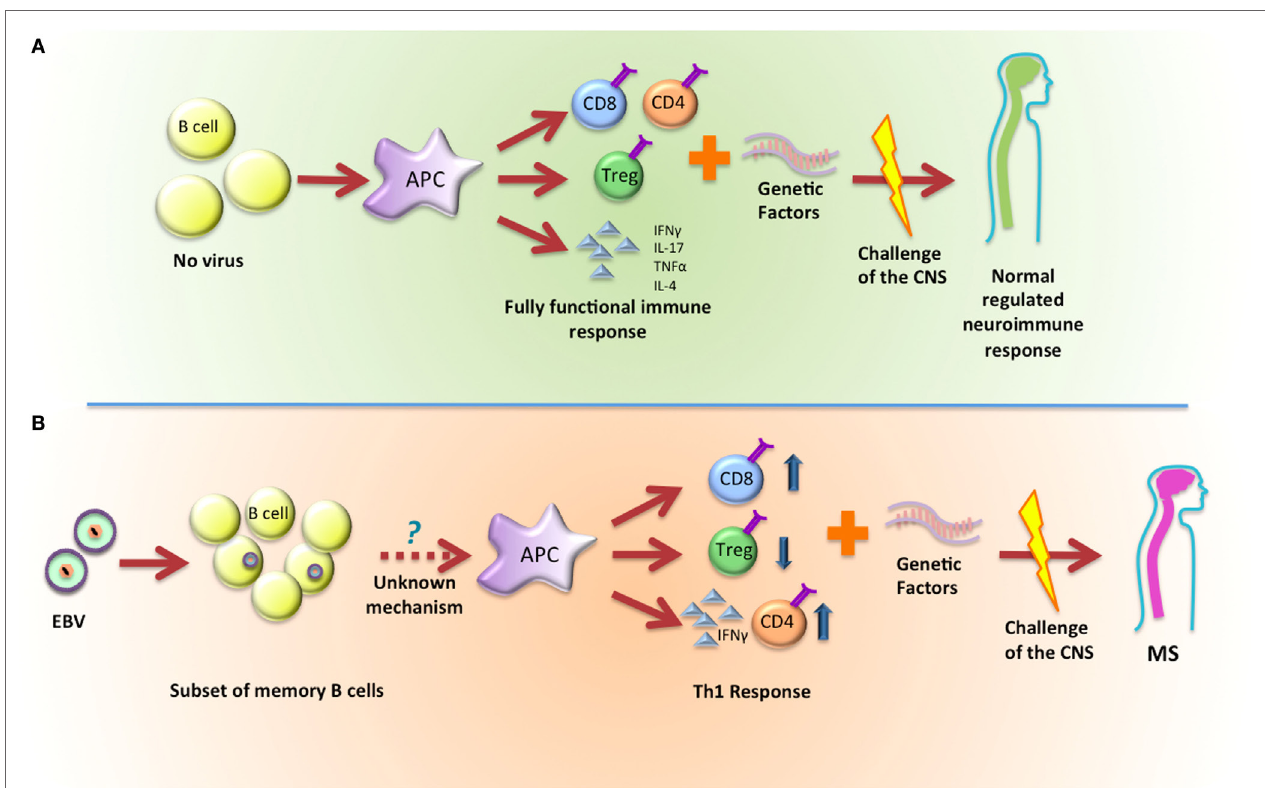
FiGURe 1 | Latent infection with eBv establishes a precondition that leads to the development of MS . (A) In normal conditions, B cells will activate APCs and, depending on the stimulus they receive, they can promote a fully functional immune response that will not impact the development of MS. (B) EBV latently infected B cells will activate APCs and promote a skewed Th1 response that, when combined with genetic factors, will lead to the development of